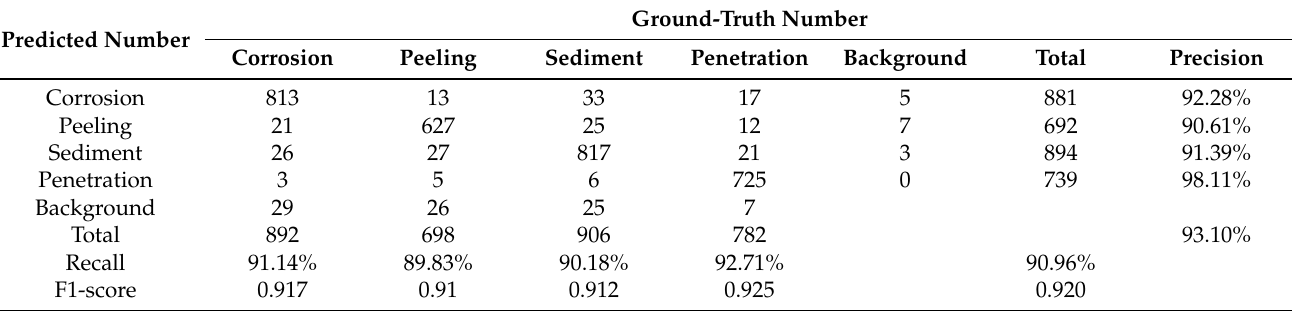
Table 1. Results of the pipeline defect detection model based on Cycle-GAN and YOLO v5.